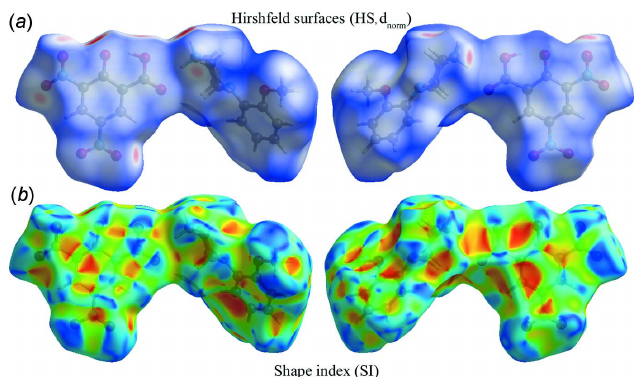
Figure 8 Two-dimensional fingerprint plots for the complete unit of the title salt indicating the various types of contacts.